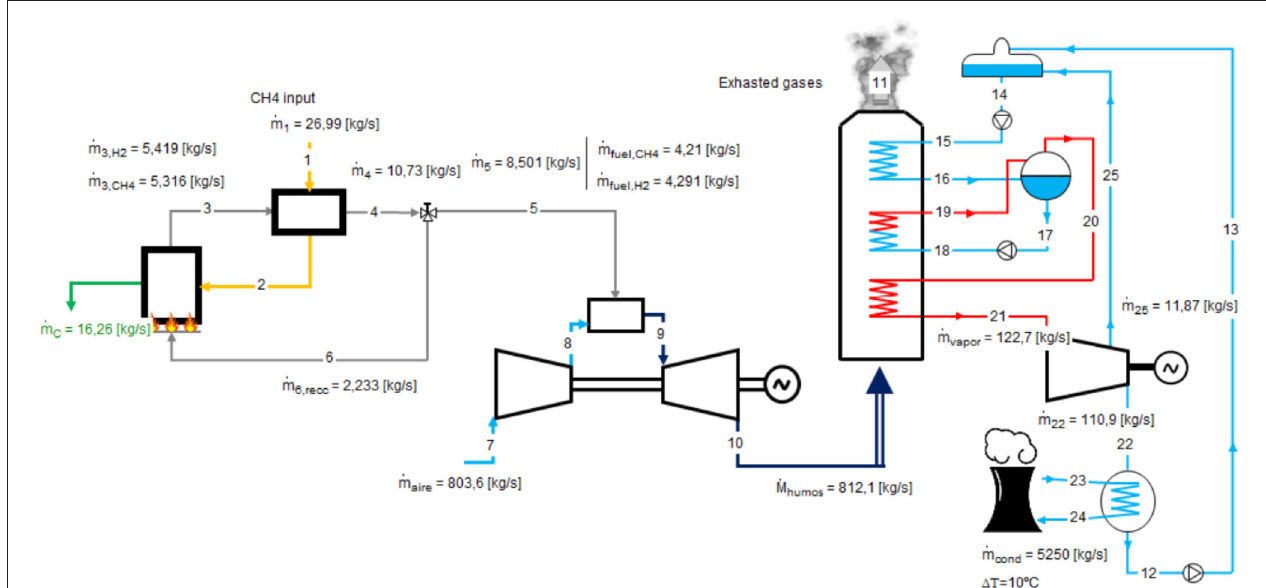
FIGURE 4 | Model for the evaluation of the application of natural gas decarbonization to a combined cycle.